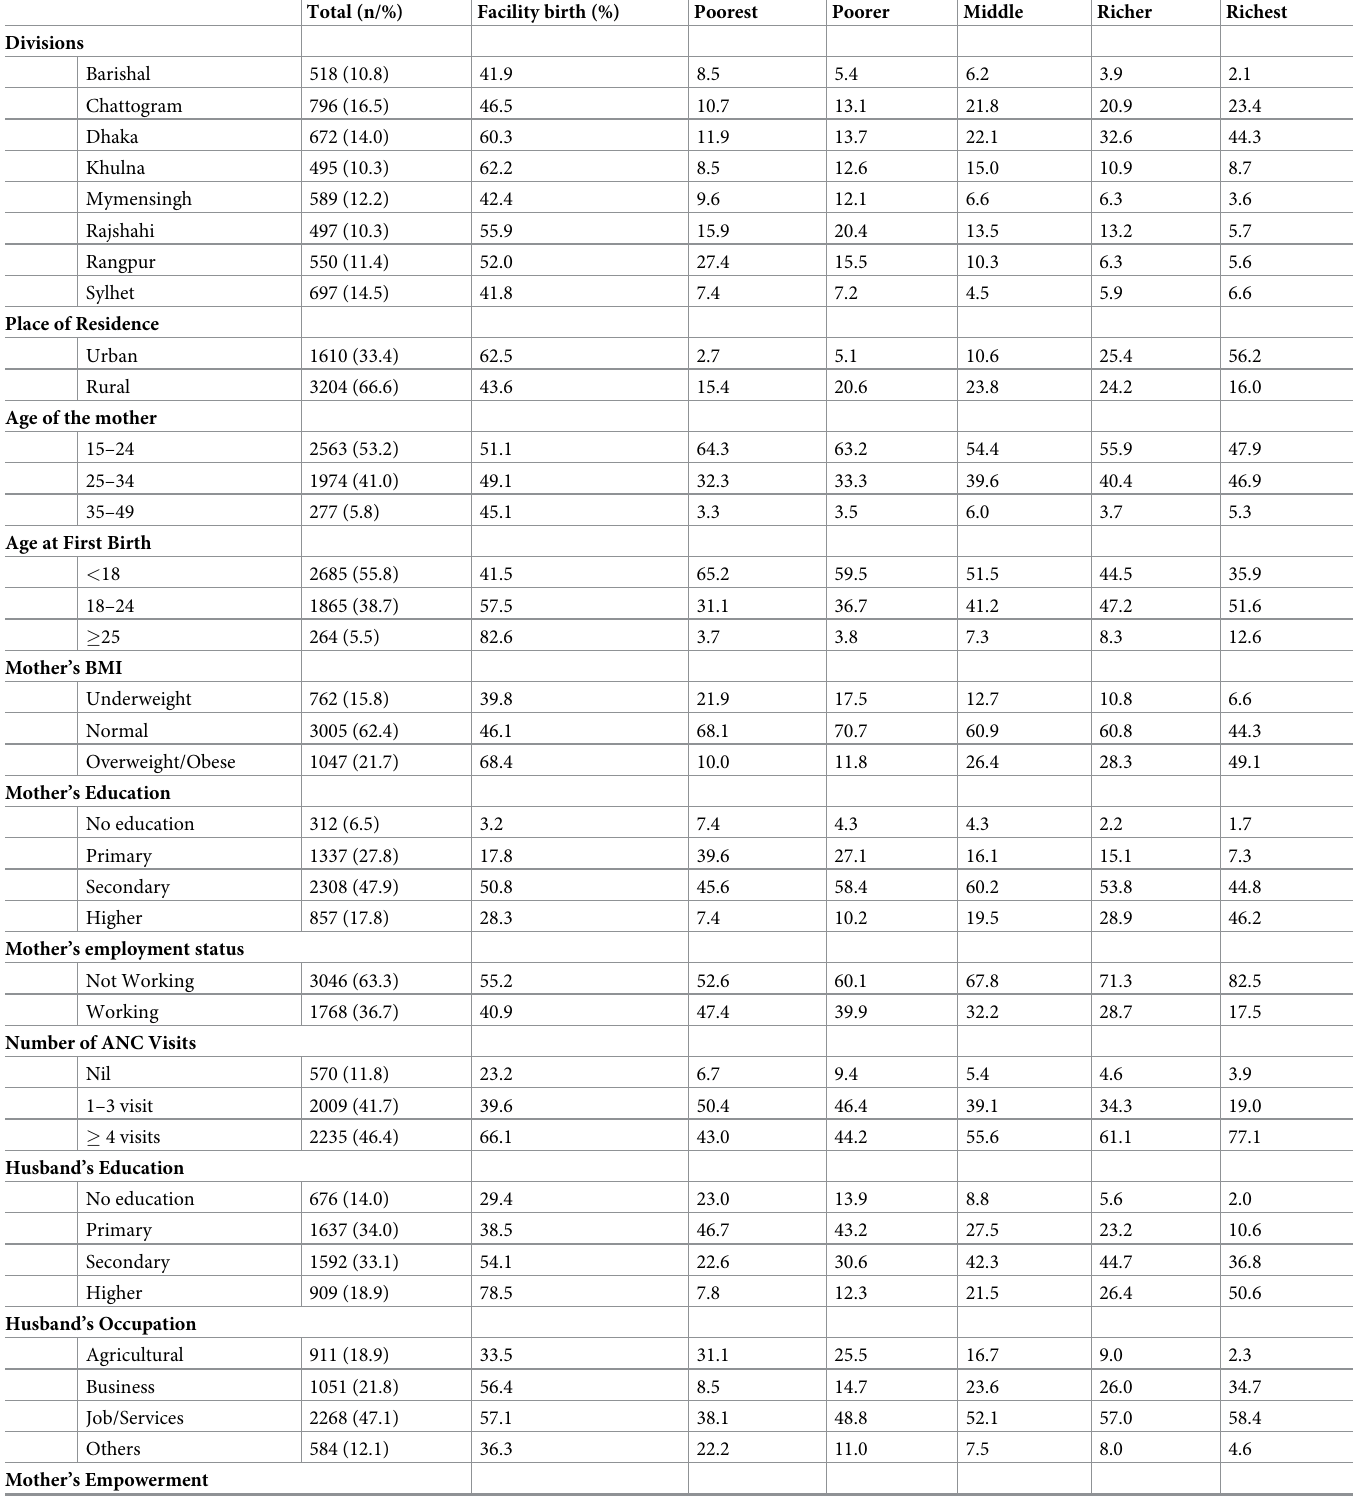
Table 2. Distribution of utilizing facility birth by analyzable reproductive aged women in Bangladesh: BDHS 2017–18. Total (n/%) Facility birth (%) Poorest Poorer Middle Richer